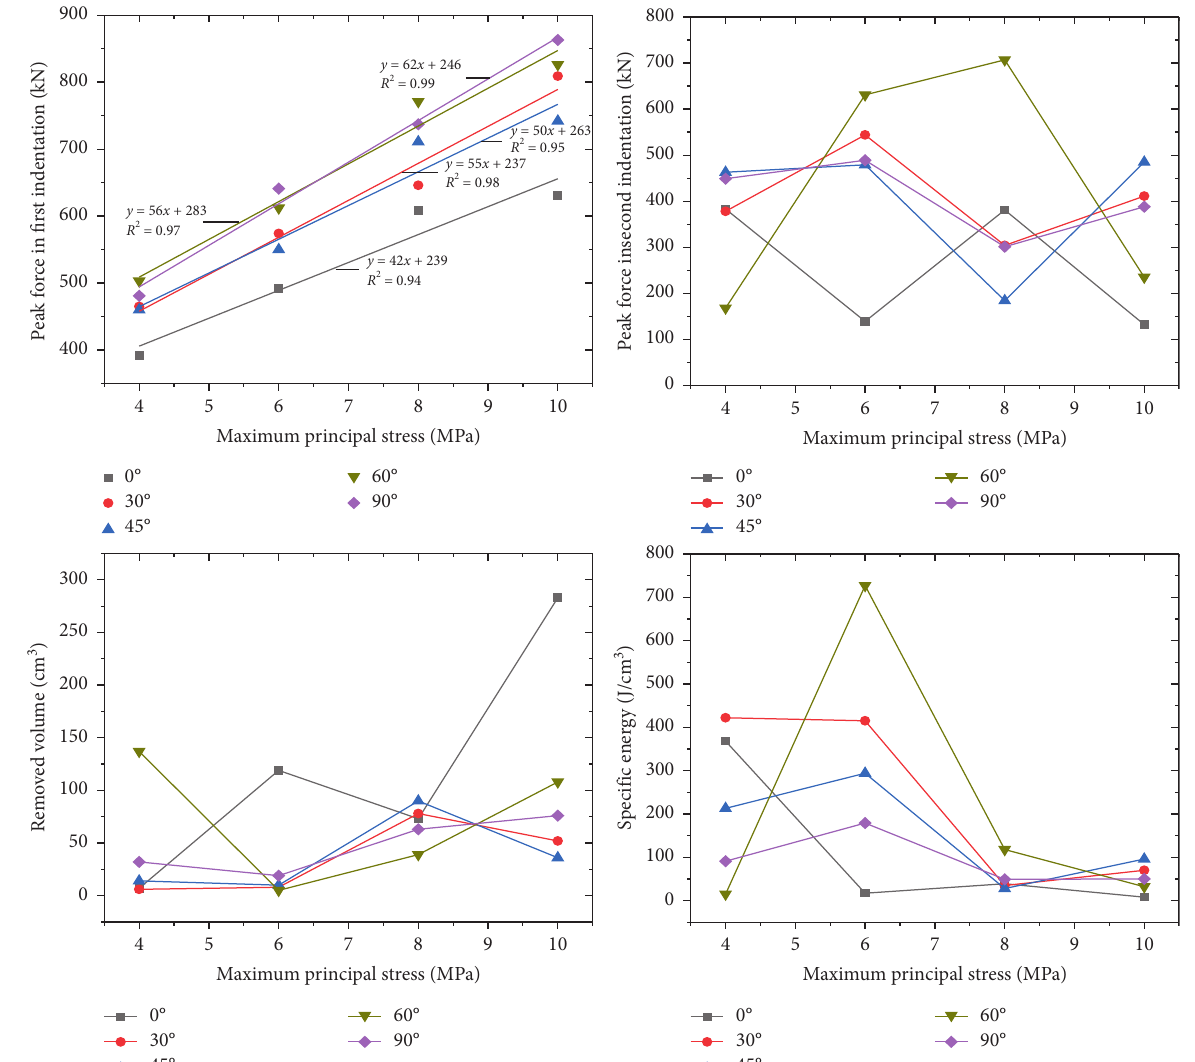
Figure 6: Comparison of the peak forces between the first and second